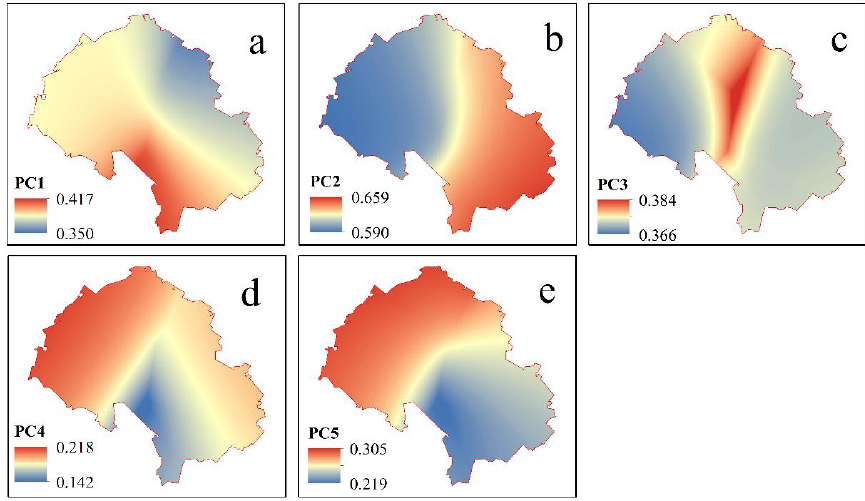
Figure 4. The spatial distribution of the standardized coefficients of principal components (PCs) in geographically-weighted regression model.